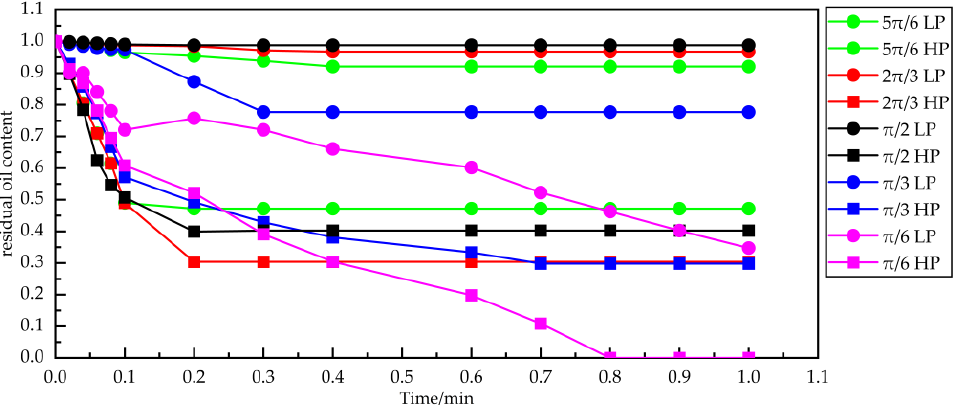
Figure 7. Curves of residual oil in the high and low permeable areas with time for different wall wetting degrees of chip 1. LP represents low permeable zone, HP represents high permeable